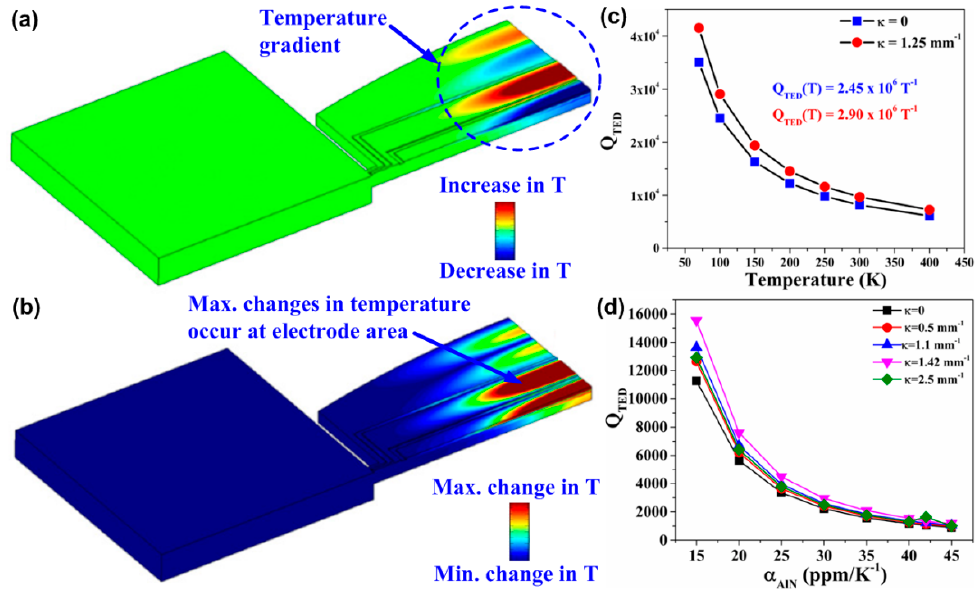
Figure 5. Evaluation of thermoelastic damping (TED) using numerical analysis: ( a ) computed thermal profile showing temperature gradients as a result of local compression and tension; ( b ) computed thermal profile showing that maximum change in temperature occurs at electrodes; ( c ) computed Q TED for both flat-edge and biconvex resonators as a function of temperature; ( d ) computed Q TED as a function of thermal expansion coefficient of AlN layer ( α AlN ) for resonators with different curvatures ( κ ). This figure is reproduced from [50] (© 2019 IOP Publishing).